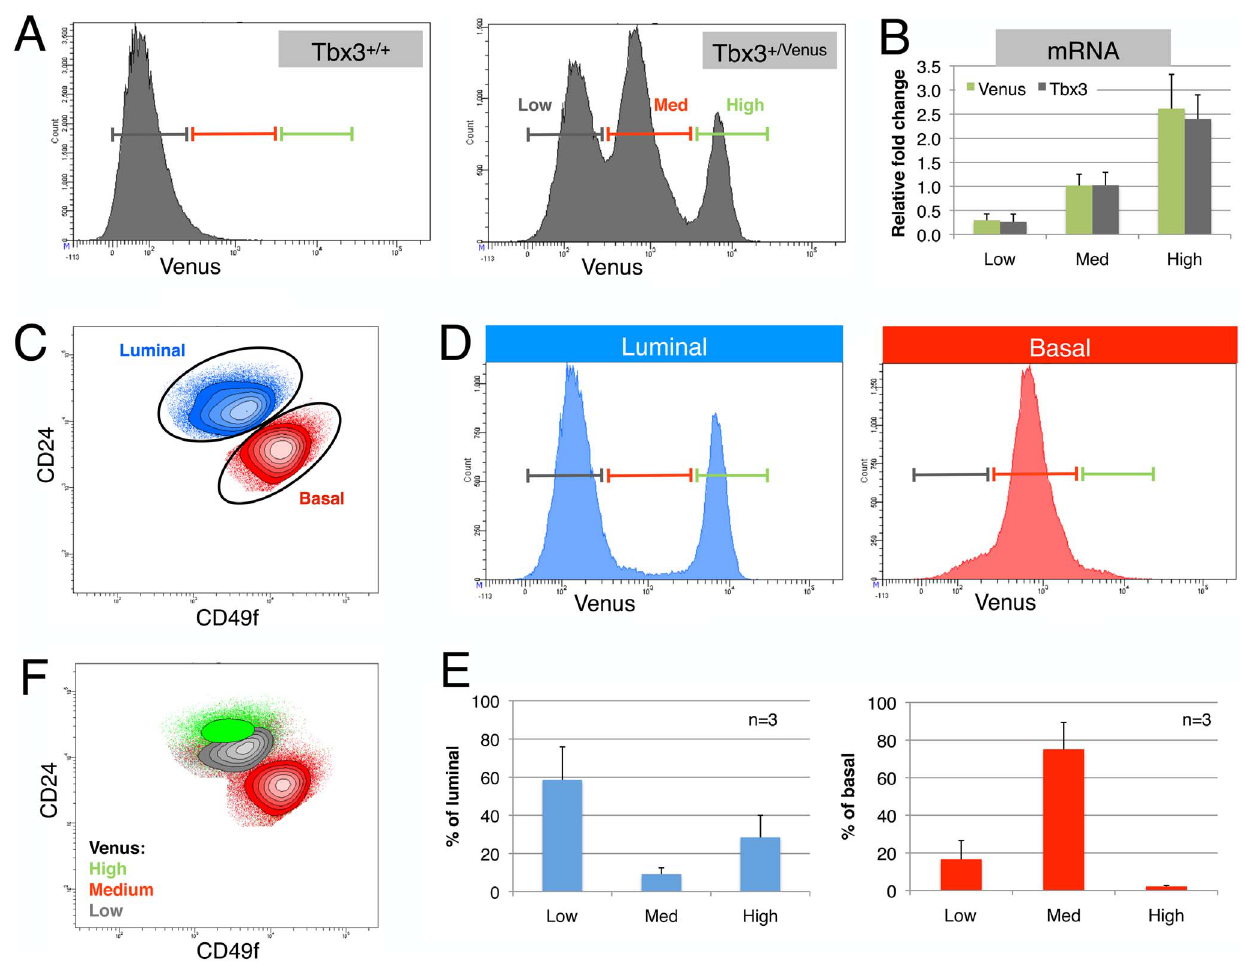
Figure 1. Fluorescent reporter reveals distinct Tbx3 expression in mammary epithelial cell subsets. (A) Epithelial cells isolated from mammary glands of wildtype (Tbx3 + / + ) or knock-in (Tbx3 + /Venus ) mice show three peaks with different levels of Venus expression (Low, Medium and High). (B) Mammary epithelial cells (MECs) from 3 independent Tbx3 + /Venus animals were sorted according to Venus signal intensity. qPCR on 500 directly lysed cells shows that both Venus and Tbx3 mRNA correlates tightly with Venus fluorescence intensity. (C) MECs were labeled with fluorescent antibodies against CD24 and a 6-integrin (CD49f) to distinguish the luminal (blue) and basal (red) cell populations. (D) When plotted separately, luminal cells from Tbx3 + /Venus mammary glands show two main populations; Venus Low (cells with low Tbx3 expression) and Venus High (cells with high Tbx3 expression). Basal cells express intermediate level of Venus (and Tbx3). (E) Quantification of the percentage of Venus-Low, -Medium and -High cells in the luminal and in the basal population of Tbx3 + /Venus epithelium. Data are presented as mean 6 SD of three individual adult virgin Tbx3 + /Venus animals. (F) Populations gated based on Tbx3 expression (Venus-Low, -Medium and -High) plotted on a CD24/CD49f contour